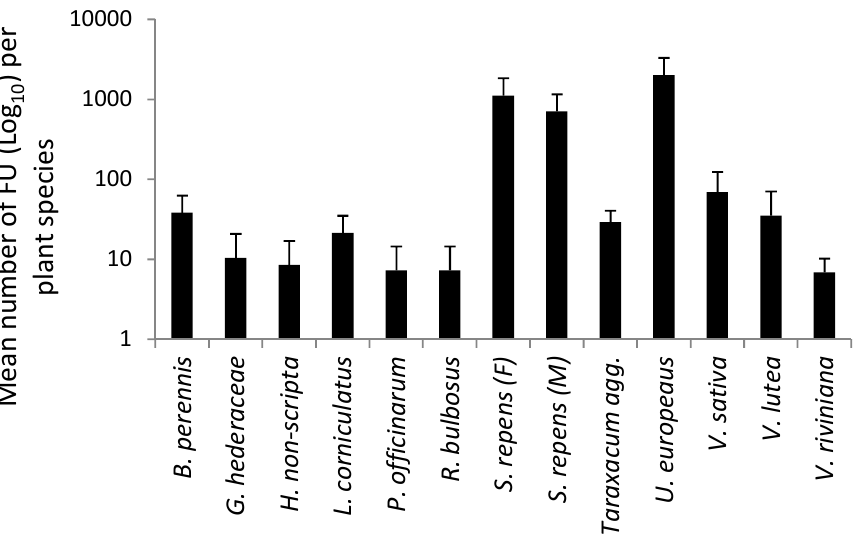
F IGURE 4. Mean floral abundance (log 10 ) ± standard error, measured by number of floral units present on average per 52 m 2 focal area in each